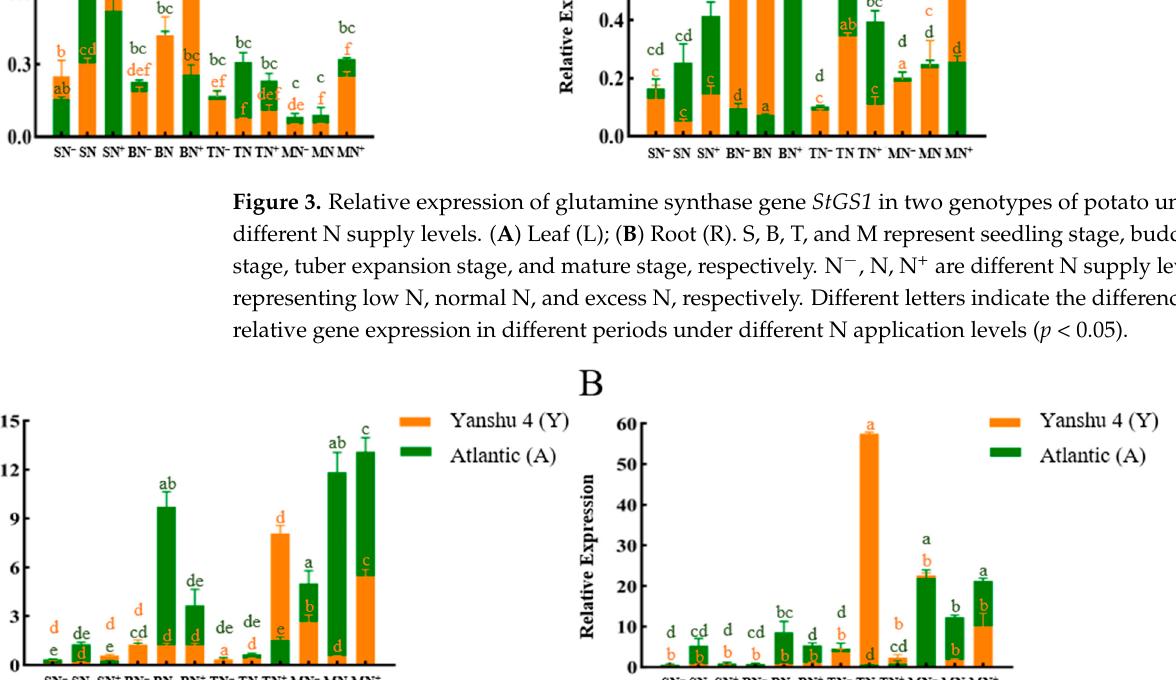
Figure 4. Relative expression of glutamine synthase gene StGS1-3 in two genotypes of potato under different N supply levels. ( A ) Leaf (L); ( B ) Root (R). S, B, T, and M represent seedling stage, budding stage, tuber expansion stage, and mature stage, respectively. N − , N, N + are different N supply levels, representing low N, normal N, and excess N, respectively. Different letters indicate the difference of relative gene expression in different periods under different N application levels ( p < 0.05).